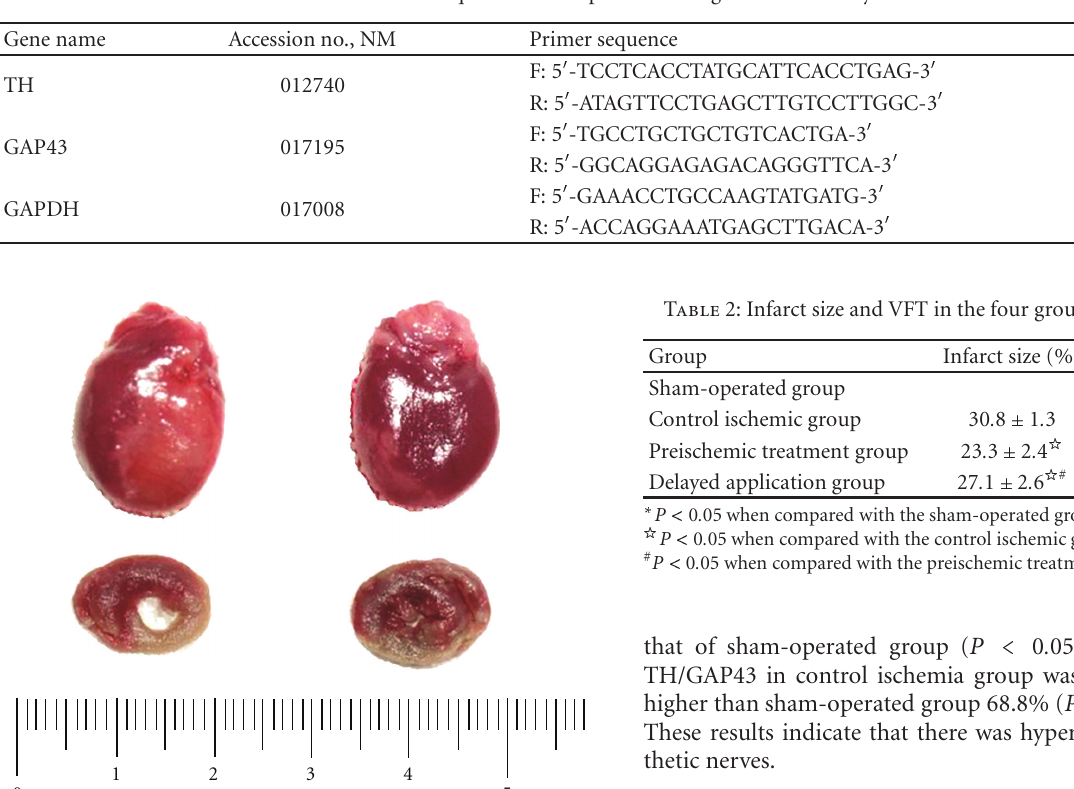
Table 1: Primer sequence and amplicon size of genes validated by RT-PCR.